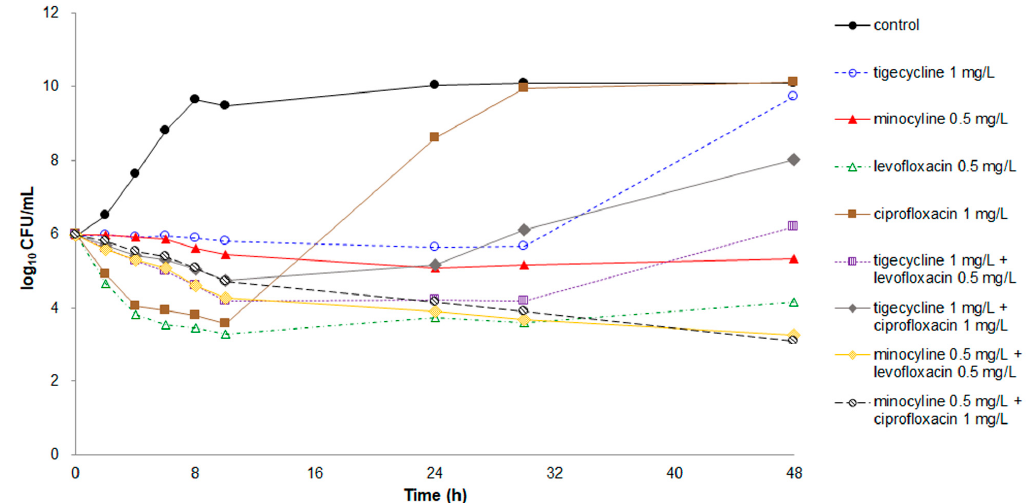
Figure 5. Time-kill assays for single and dual-agent combinations with 2 × MIC against E. anophelis strain ED853-49. Data points represent the mean of three experiments. Minocycline: MIC, 0.25 mg/L; tigecycline: MIC, 0.5 mg/L; ciprofloxacin: MIC, 0.5 mg/L; and levofloxacin: MIC, 0.25